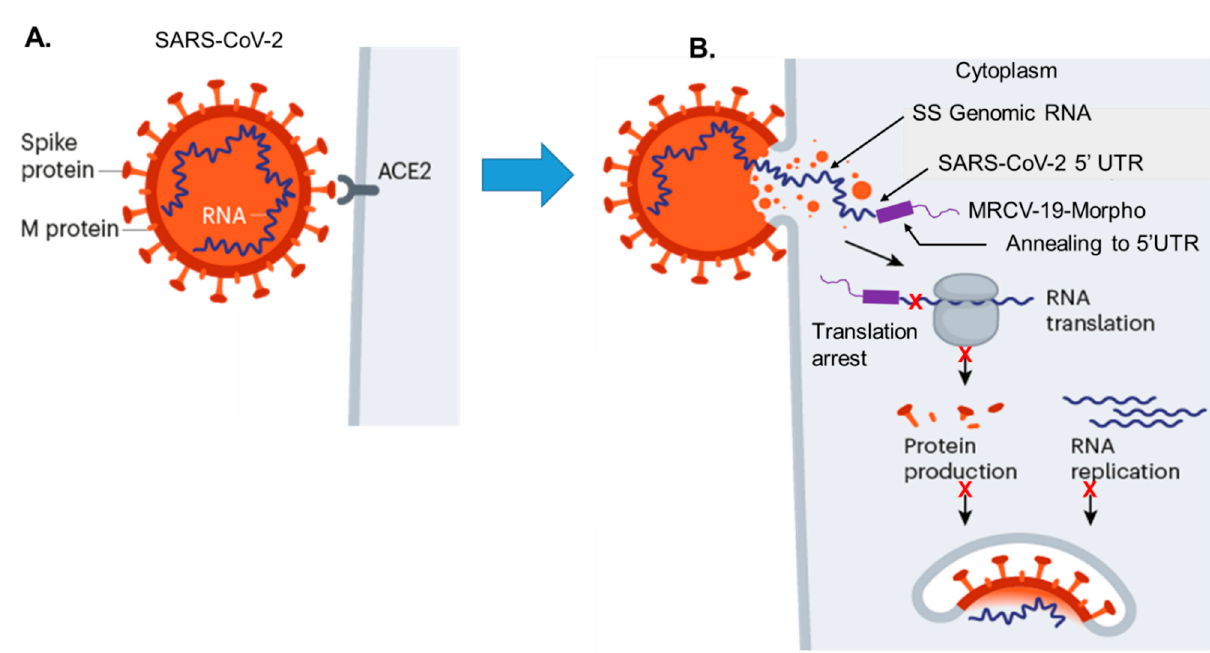
Figure 1. A model for MRCV-19 morpholino inhibition of SARS-CoV-2 protein expression translation arrest. ( A ) SARS- CoV-2 binding to the ACE2 receptor via the spike glycoprotein on permissive cells to initiate infection. ( B ) The release of single-stranded viral genomic RNA, and sequence-specific binding of MRCV-19 (GT4) to the 5 ′ UTR of the pp1a gene loci to inhibit viral protein translation.